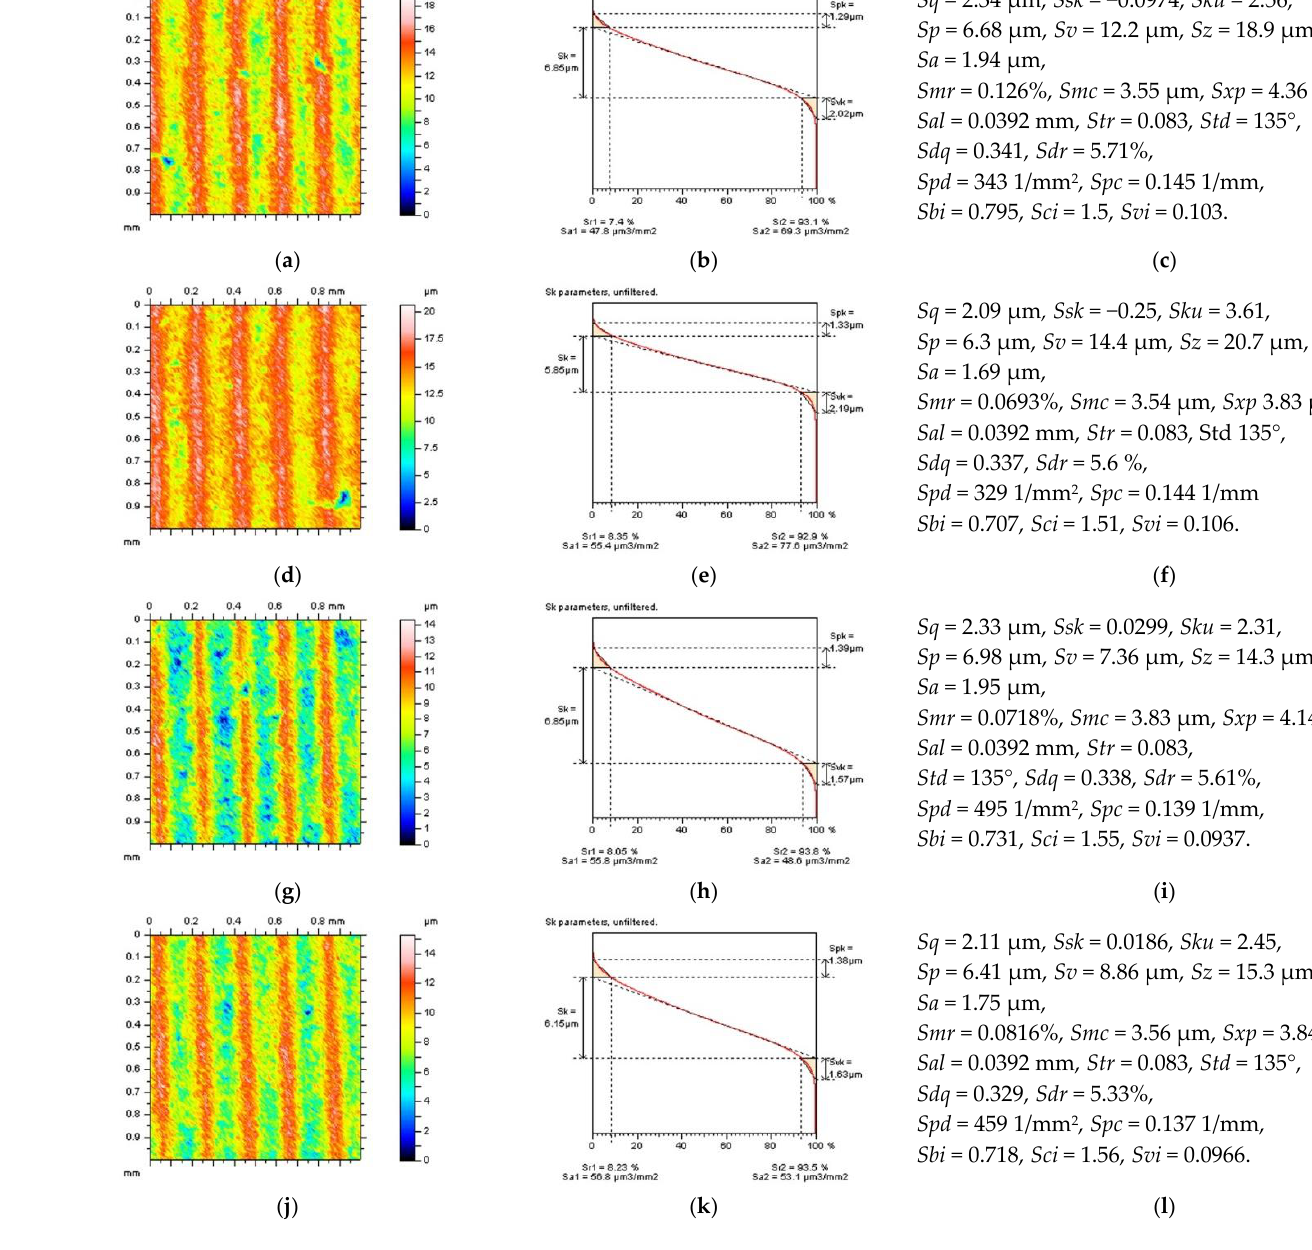
Figure 4. Contour map plots (left column), material ratio curves (middle), and ISO 25178 topography parameters (right column) of the turned surface received from the surface after a feature-based dividing process: surface A with one valley feature and one pit feature ( a – c ), surface B with one valley feature ( d – f ), surface C with one pit feature ( g – i ), and surface D not containing any extraordinary features ( j – l ).